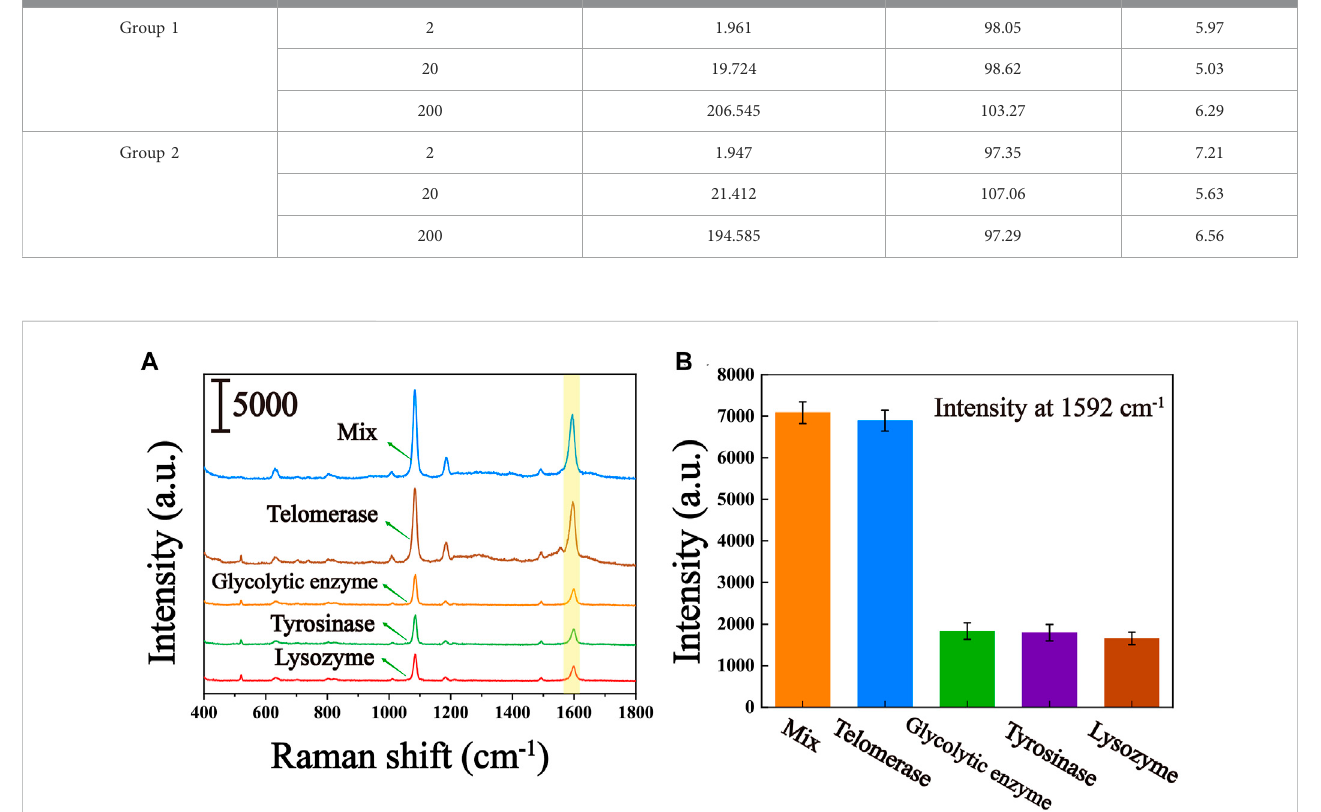
FIGURE 6 Speci fi city of the telomerase activity assay (controls include glycolytic enzymes, tyrosine, lysozyme, and their mixtures with telomerase). (A) Average SERS spectra of several interferents. (B) The corresponding histogram of the peak intensity at 1,592 cm − 1